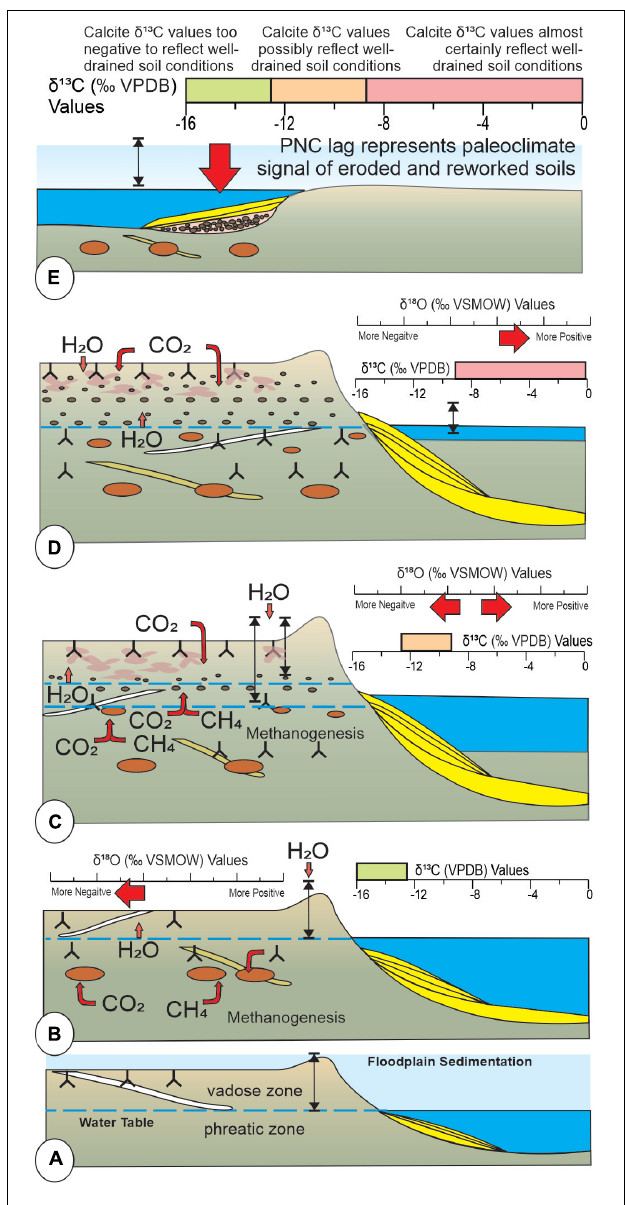
FIGURE 9 | Generalized aggradational/degradational landscape model coupling the phase of interfluve development, water-table, carbon source for calcite cement, and δ 13 C and δ 18 O values associated with pedogenic calcite-cemented nodules formed under these parameters (after Gastaldo et al., 2020b). (A) Initial aggradational phase with rooting and invertebrate bioturbation of the upper soil horizons accompanying overbank deposition. (B) Second phase of floodplain aggradation where rate of overbank deposition is high. Immature soils are buried in the phreatic zone due to a rise in watertable. Anaerobic decay of organic matter releases both CO 2 and CH 4 into pore waters, adding HCO 3 and modifying acidity, promoting calcite precipitation around organic nucleus. Values of both δ 13 C and δ 18 O of calcite cements are more negative. (C) Third phase of overbank aggradation with a reduced frequency of overbank deposition and greater seasonality. Pedogenesis over longer time scales and greater variance in seasonal rainfall results in greater flux and penetration of the watertable, affecting δ 13 C and δ 18 O values of calcite cements. δ 13 C values reflect precipitation